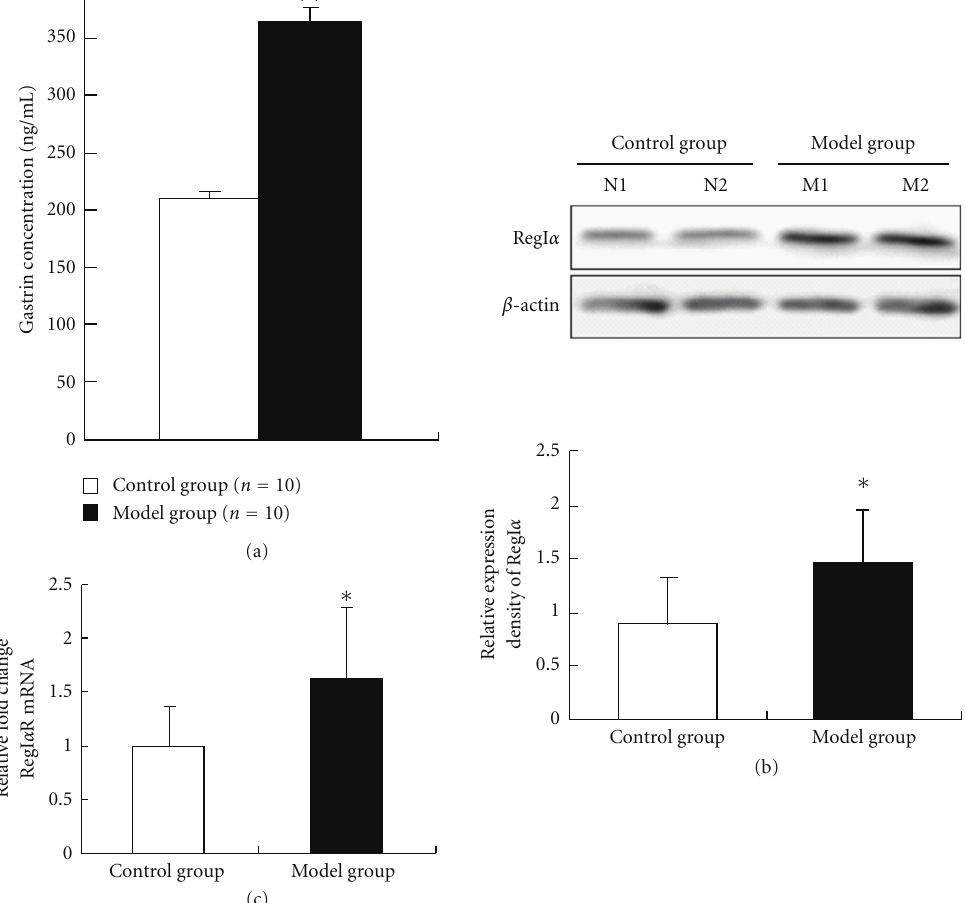
Figure 3: The RegI α protein and its receptor mRNA were overexpressed in atrophic gastritis rats with hypergastrinemia. (a) The average serum gastrin levels (ng/mL) in atrophic gastritis and normal rats were determined by ELISA assay. (b) Representative results of RegI α protein expression in gastric tissues from atrophic gastritis and normal rats (upper lane) were performed by immunoblot experiments. Band densities were quantified and protein levels were normalized to β -actin (lower diagram). (c) The expression of RegI α receptor mRNA was measured by quantity real-time PCR and calculated using the value of 2 − ΔΔ CT . Relative fold change in atrophic gastritis group was compared with that of normal group, which was normalized as a reference value of 1.0. Control group: normal control rats; Model group: atrophic gastritis rats. ∗ P < 0 . 05, ∗∗ P < 0 .